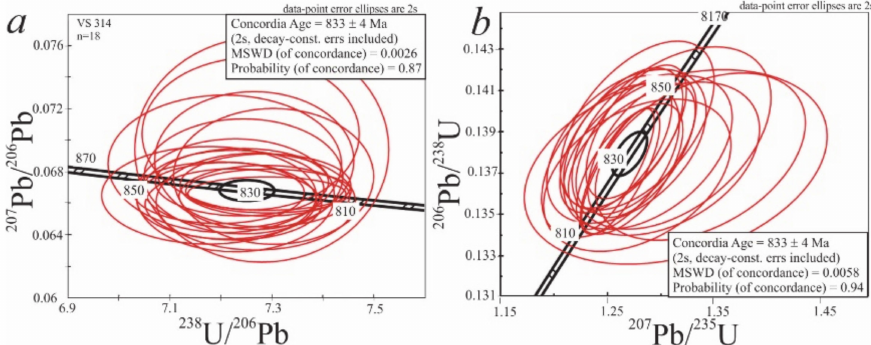
Figure 16. Pb–Pb and U–Pb concordia diagrams of zircons from trachyandesite: ( a ) 238 U / 206 Pb vs. 207 Pb / 206 Pb and ( b ) 207 Pb / 235 U vs. 206 Pb / 238